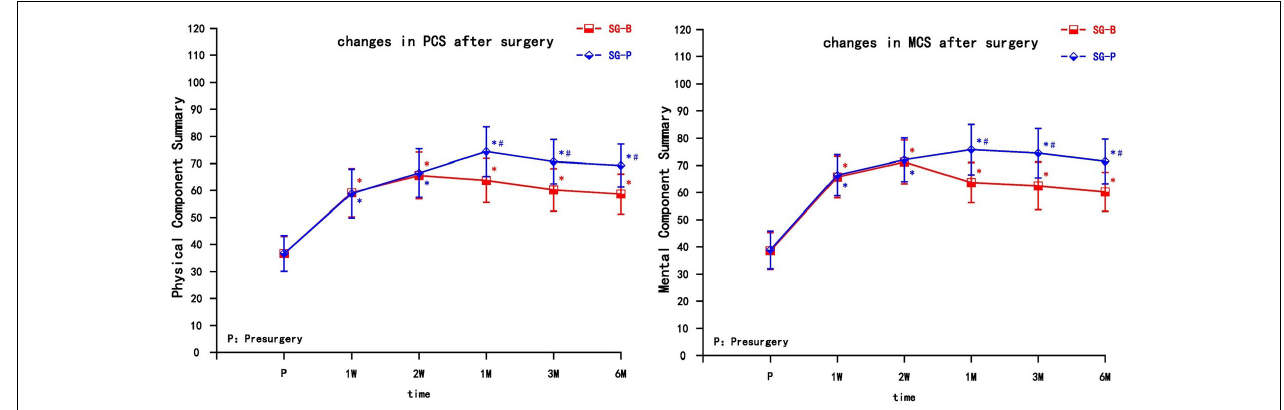
FIGURE 3 | Comparison of quality of life scores (SF-36) pre-surgery and post-surgery in the two groups. At 1 and 2 weeks, PCS and MCS increased in both groups ( P > 0.05); PCS and MCS increased significantly in the SG-P group after 1 month ( P < 0.05). PCS, Physical Component Summary; MCS, Mental Component Summary; Results are presented as means ± SEMs. ∗ Compared to pre-surgery, P < 0.05; # Compared with SG-B group, P <